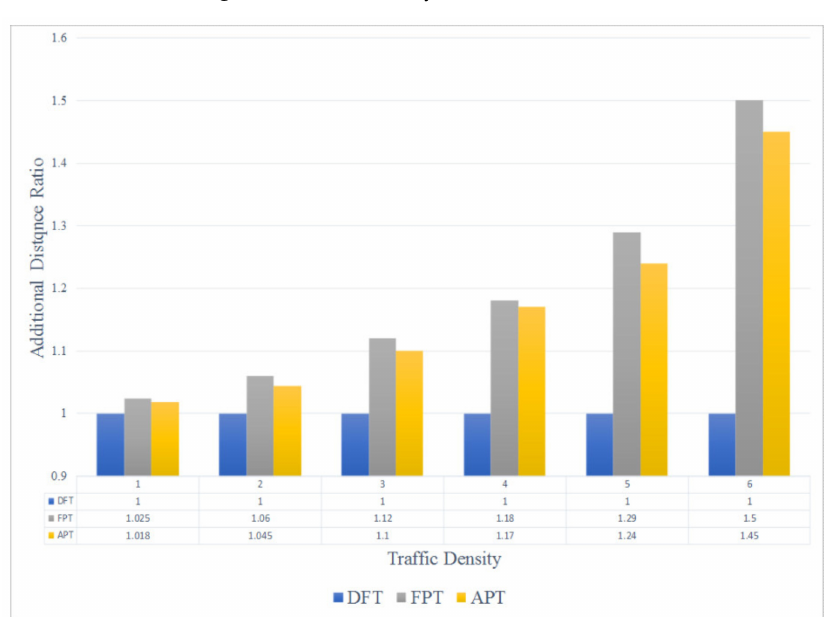
Figure 7. Tra ffi c density vs. additional